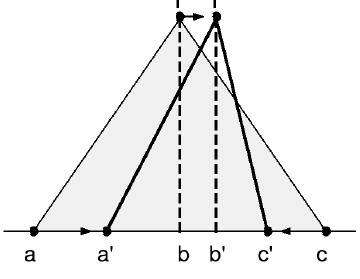
Fig. 8. Tuning by changing the basic MF parameters.